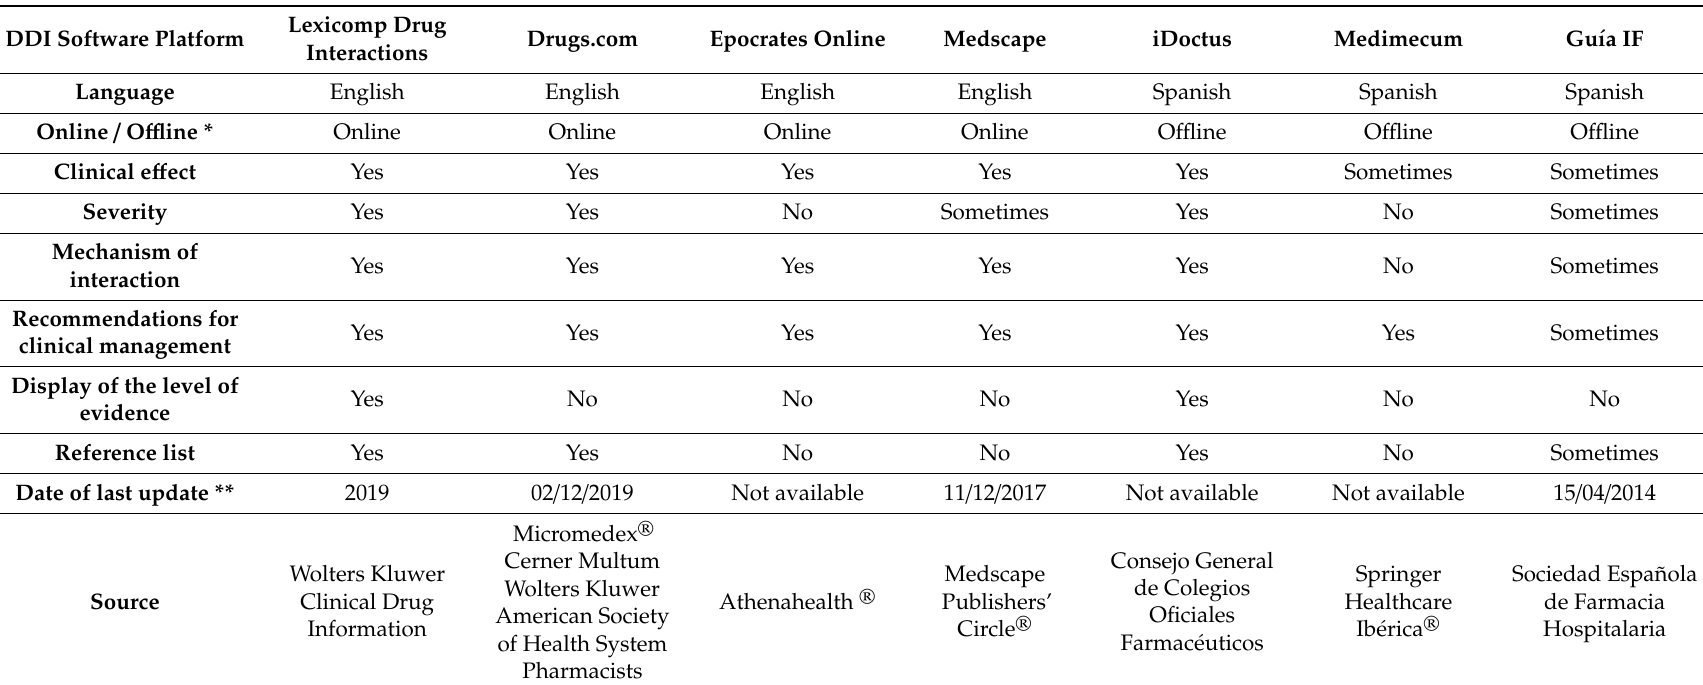
Table 2. Capabilities and main features of the selected drug–drug interaction software